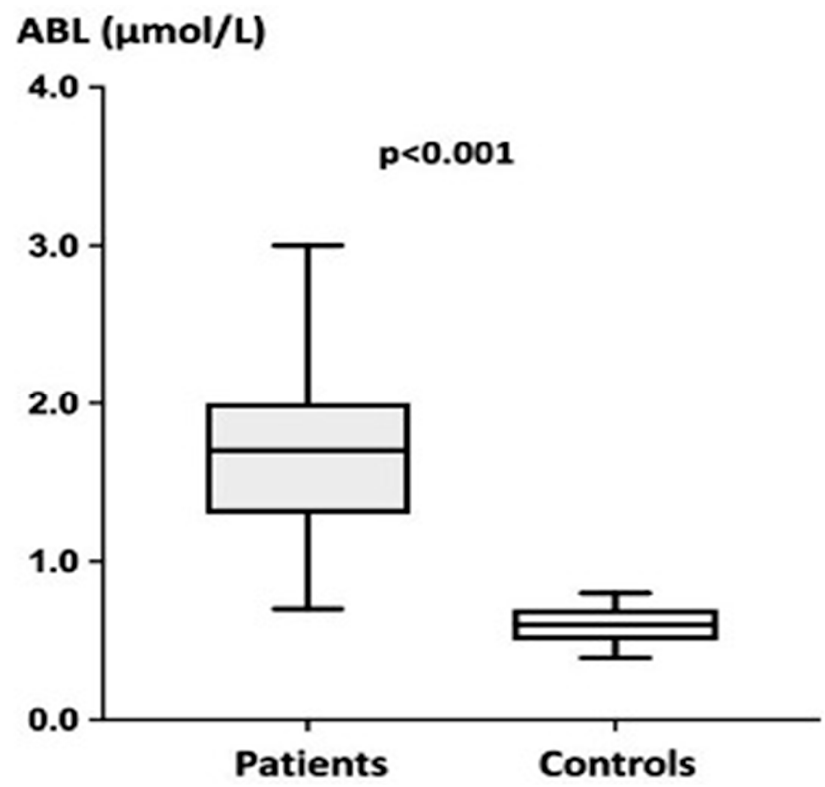
Figure 1. Comparison of adenosine blood levels in patients with fibromuscular dysplasia ( n = 67) and healthy subjects ( n = 40). Patients: ( median and range ) : 1.70 (0.7–3.0) µ M vs. Controls = 0.60 (0.4–0.8) µ M, p <